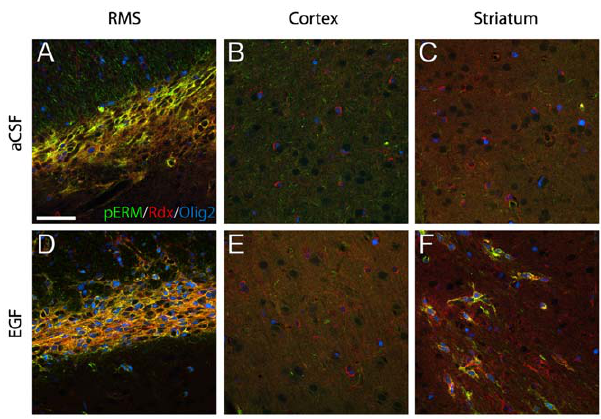
Figure 7. Phosphorylation of radixin in EGF-induced Olig2 + cells. Radixin (Rdx) activation was determined using an antibody that recognizes the phosphorylated form of ERM (ezrin, radixin, and moesin) proteins (pERM). ( A, D ) In the control rostral migratory stream (RMS), coexpression of radixin (red) and pERM (green) was predominantly observed in Olig2-negative neuroblasts. In the EGF-treated RMS the majority of radixin + /pERM + cells was also Olig2 + (blue) cells. ( B, E ) No pERM expression was found in the cortex of either control or EGF- treated animals. ( C, F ) In the striatum, EGF infusion induced the presence of pERM + /radixin + /Olig2 + cells, which was not observed under control conditions ( C ). Scale bar in A=50 m m. RMS, occasionally expressed CNPase (Figure 8A) or NG2 (Figure 8B). The overall CNPase and NG2 expression pattern appeared not to be altered by EGF (Figure 8A and B).